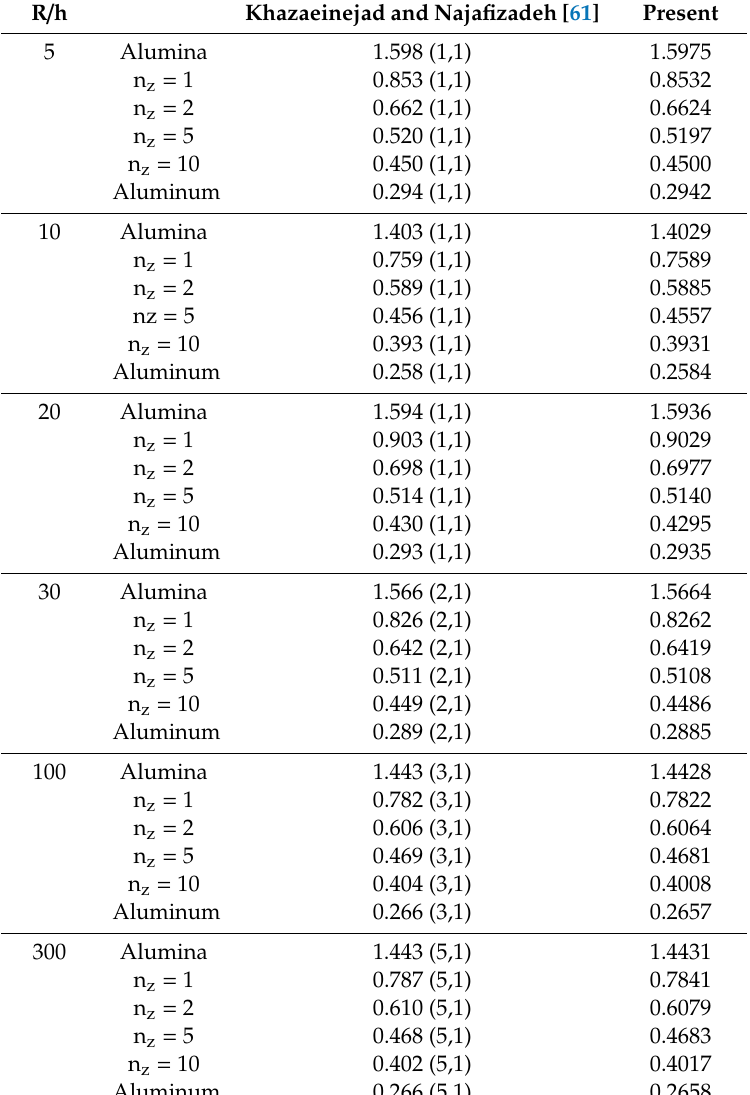
Table 1. Comparative evaluation of the critical axial buckling load (MN) for a FG cylindrical shell